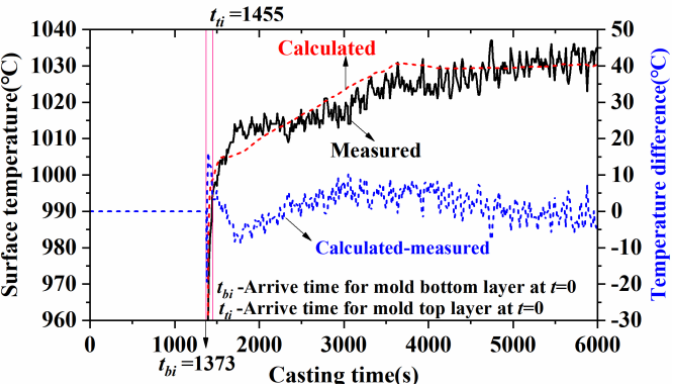
Figure 5. Calculated surface-center temperatures vs. measurements at z = 12 m (distance from meniscus).